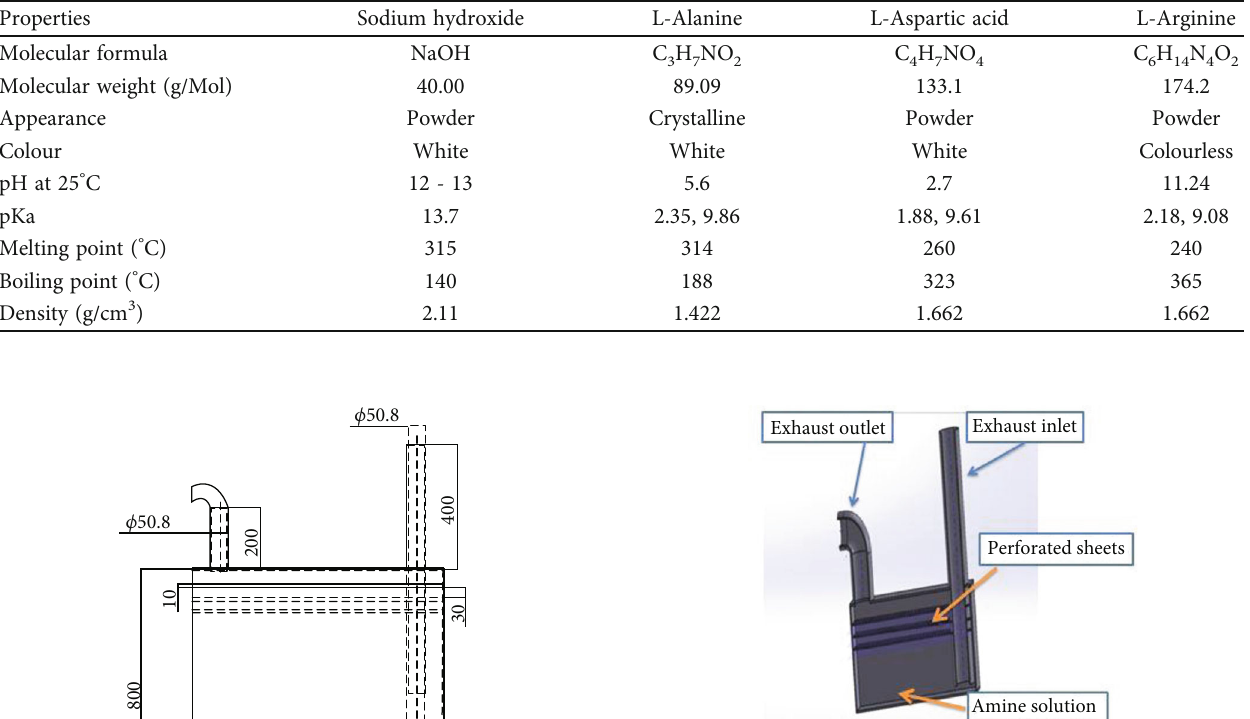
Table 1: Important properties of amines used.